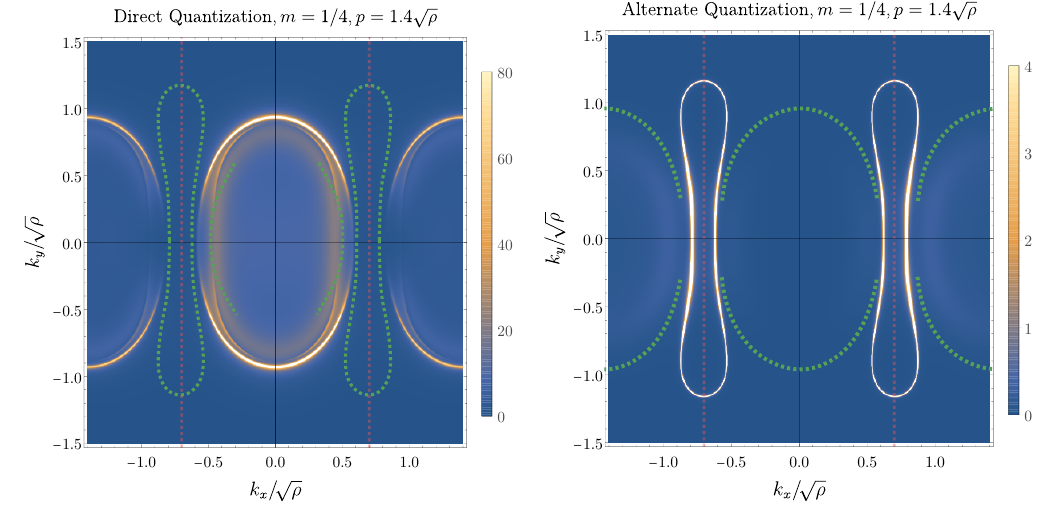
Figure 8 . Poles and zeros of the fermionic response in strong holographic lattices ( (cid:21) = 8 : 0 ). Looking more closely at the spectral densities for large lattices and small BZ ( p = 1 : 4 direct quantization in the left (cid:12)gure the spectral density broadens and disappears near the Umklapp p surfaces k x (cid:6) 0 : 7 (cid:26) . When tracing out the Fermi surfaces in direct and alternate quantizations and overlaying them on top of each other, it becomes apparent that when the Fermi surfaces of the two di(cid:11)erent quantization would lie at the same point, they both experience a reduction and broadening of the spectral weight near the FS. The secondary Fermi surface of the alternate quantization is also shown as a trace on the left. This is not visible on the right-hand picture due to the choice of color scheme (see the log-scale (cid:12)gure 6